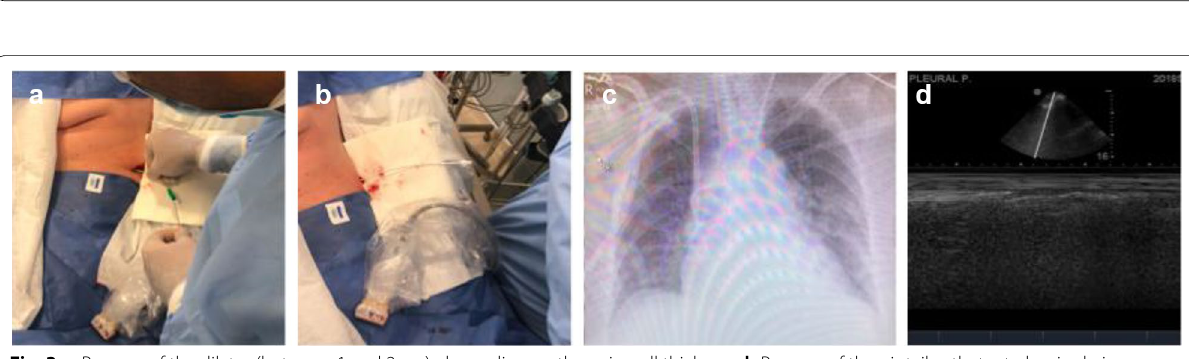
Fig. 3 a Passage of the dilator (between 1 and 2 cm), depending on thoracic wall thickness. b Passage of the pigtail catheter to begin drainage. c Chest X-ray after drainage showing a fluid-free pleural cavity. d Ultrasound verification, with a sector transducer, of a fluid-free pleural cavity, also dismissing the presence of pneumothorax (“sand-on-the-beach”